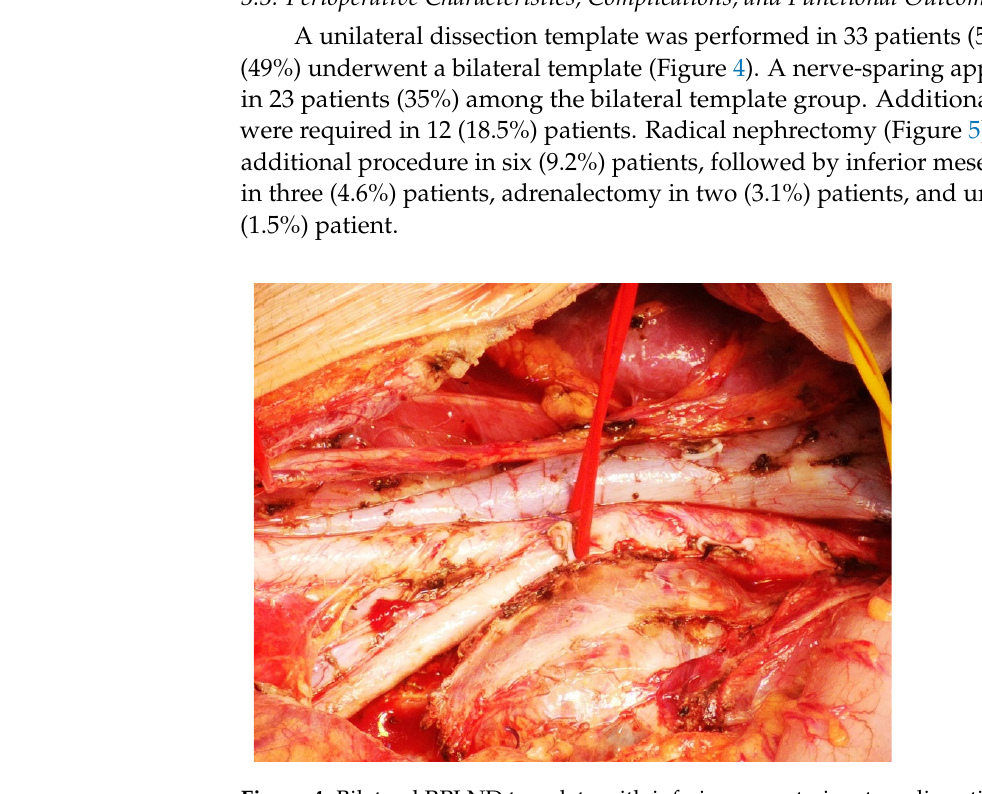
Figure 5. Radical nephrectomy during retroperitoneal lymph node dissection. 3.4. Oncological Outcomes At survival analyses, OS and RFS were 87.7% and 84.6% at 20-year follow-up, respec- tively (Figure 6). No statistically significant difference was found in terms of OS among patients undergoing primary RPLND vs. secondary RPLND ( p = 0.44). Likewise, no